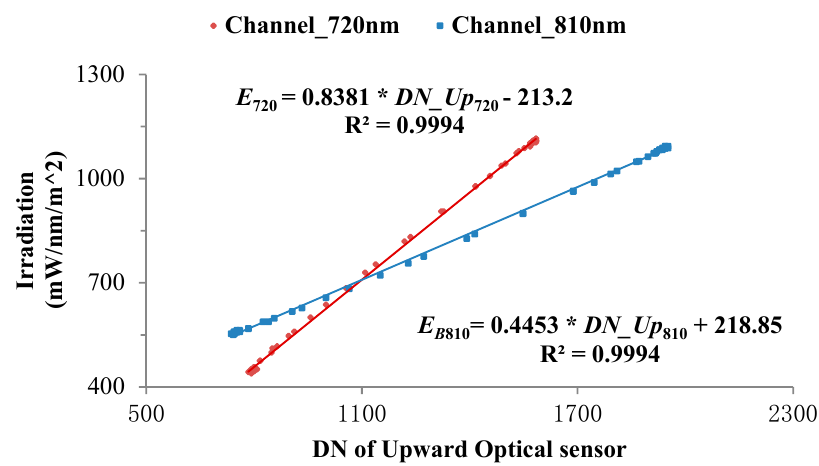
Figure 11. Calibration curve for irradiances received by the upward optical sensor.